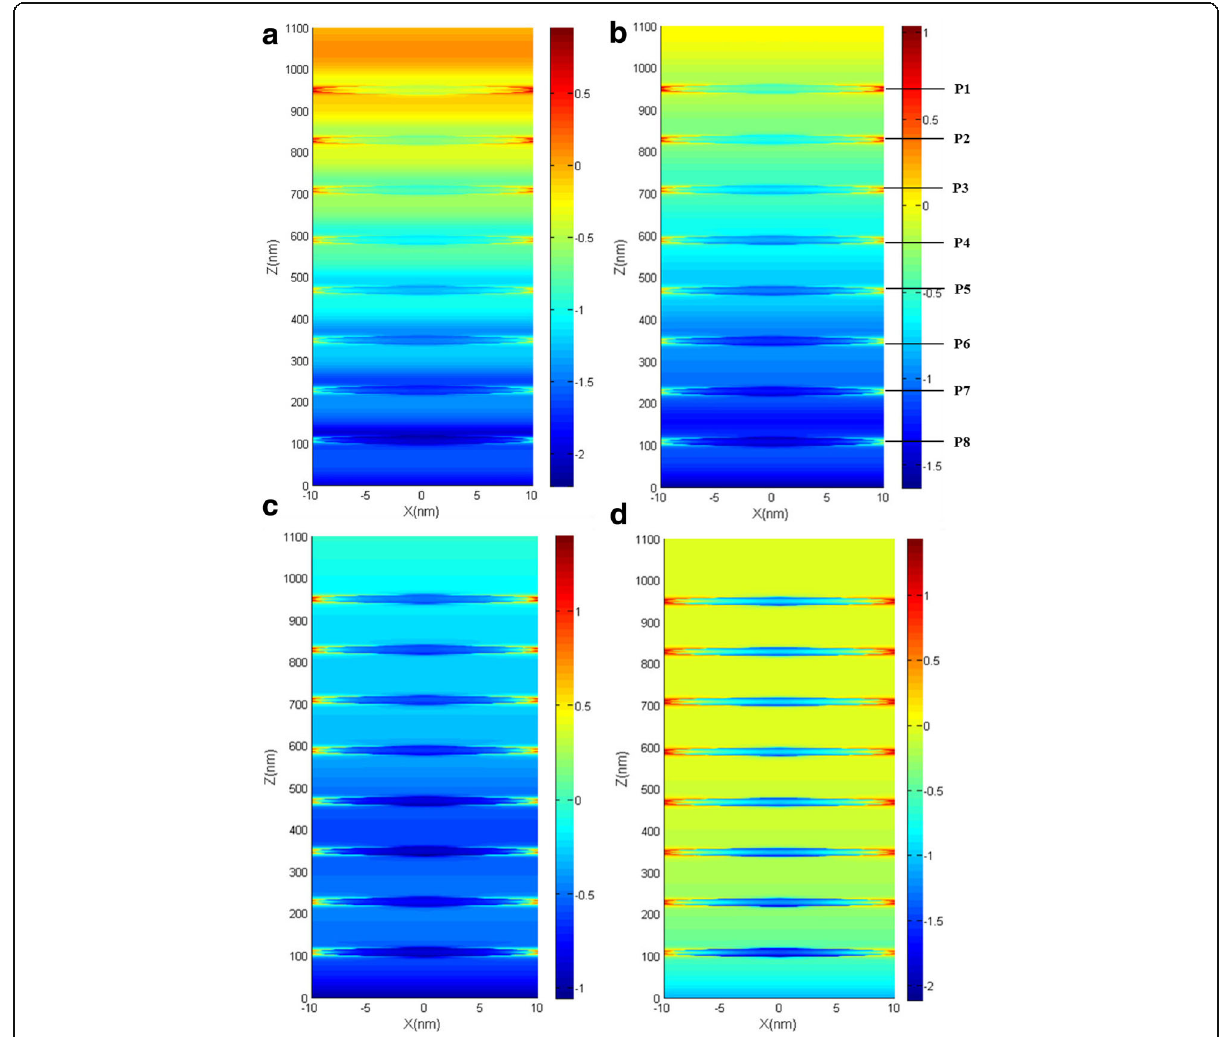
Fig. 6 Electric magnitude distribution (log 10 | E / E 0 |) of the eight-MD-pair NPA structure in the y = 0 plane at a 441 nm, b 638 nm, c 1580 nm, and d 2500 nm. p1 – p8 represent the eight particles in the one unit cell of the eight-MD-pair NPA structure